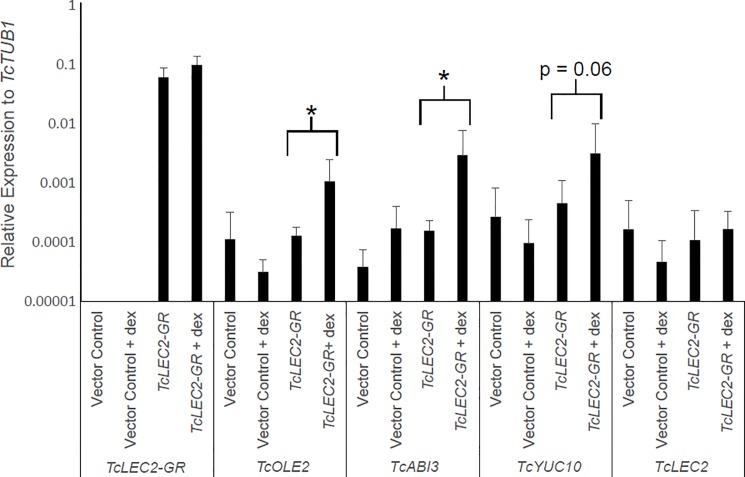
qRT-PCR analysis of TcLEC2-GR leaf explants exposed to 10 μM dex for 14 days.Relative expression of embryogenesis-associated transcripts was calculated relative to housekeeping gene TcTUB1. Bars represent mean relative expression from five replicates with standard errors. Asterisks denote statistical significance determined using REST software [32].